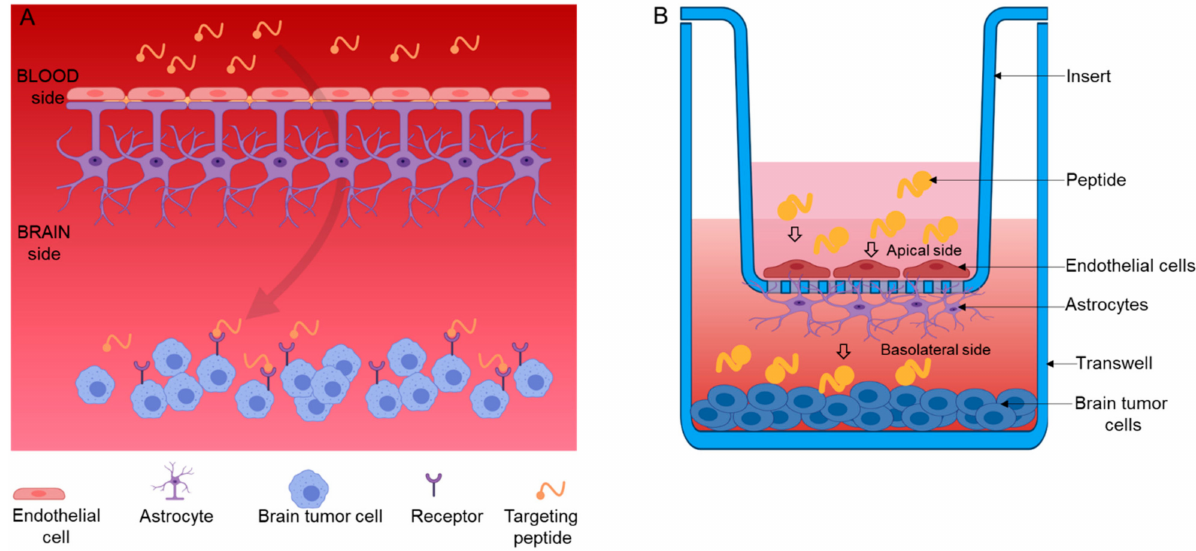
Figure 2. Schematic illustration of targeting peptide transport across the blood–brain–barrier (BBB) in both ( A ) in vivo and ( B ) in vitro models. Figure was created with BioRender.com. (Access on 28 February